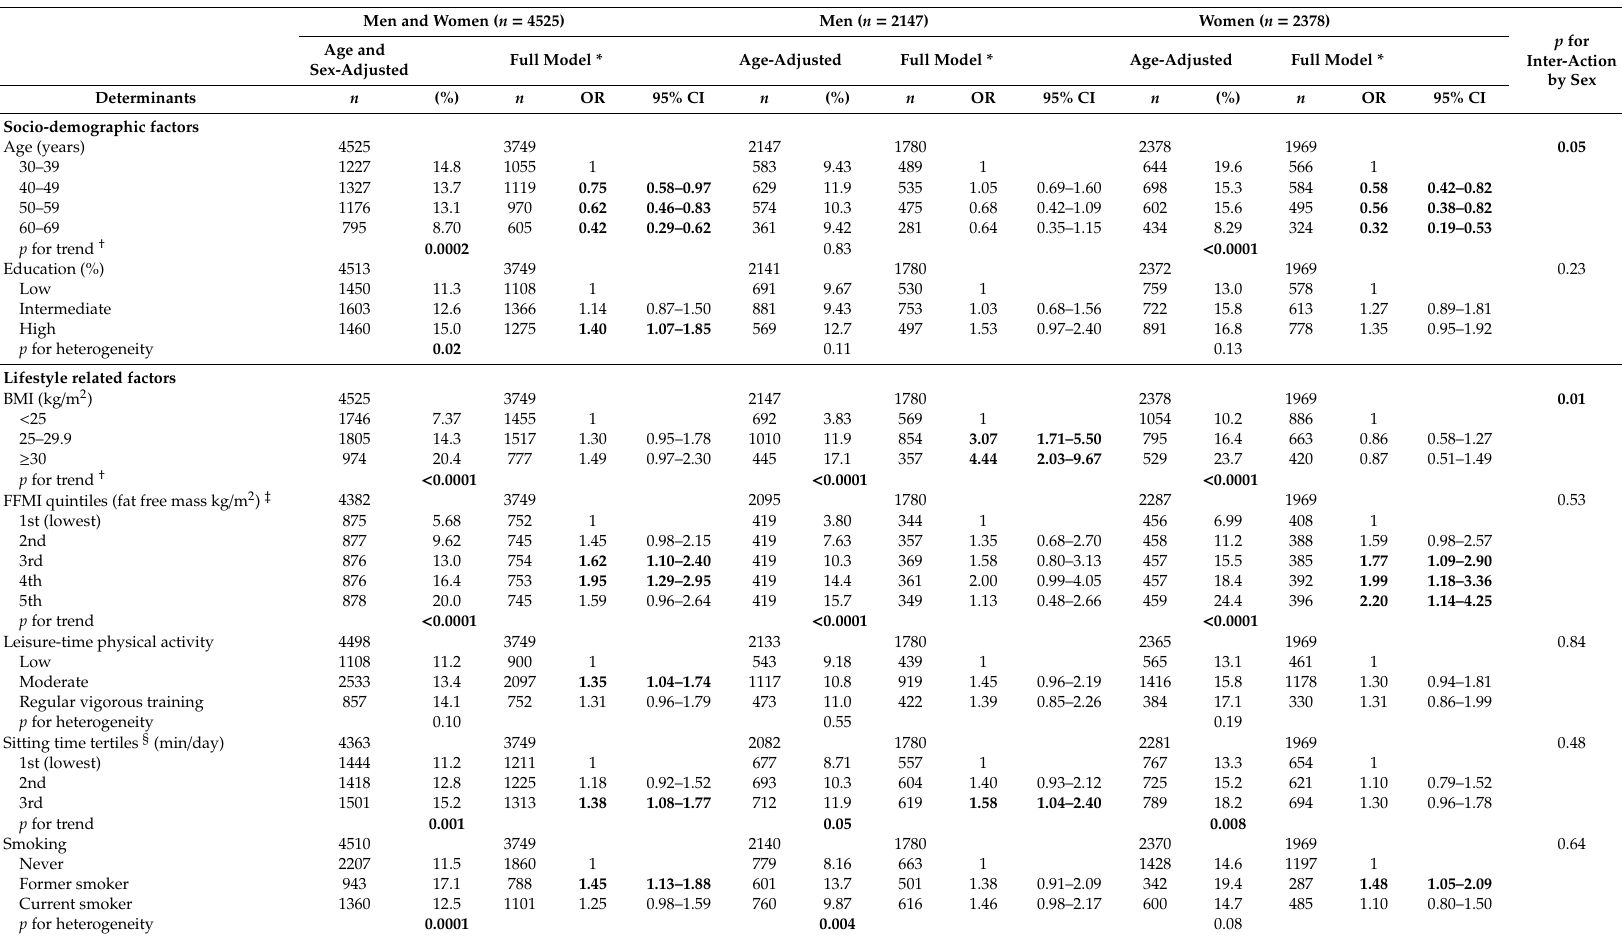
Table 3. Self-report IWL during the previous year in men and women by potential determinants ( n =